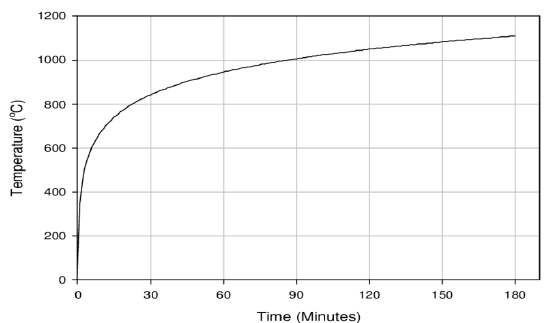
Figure 4. Time–temperature curve of the KS F 2257 (ISO 834) standard [35].